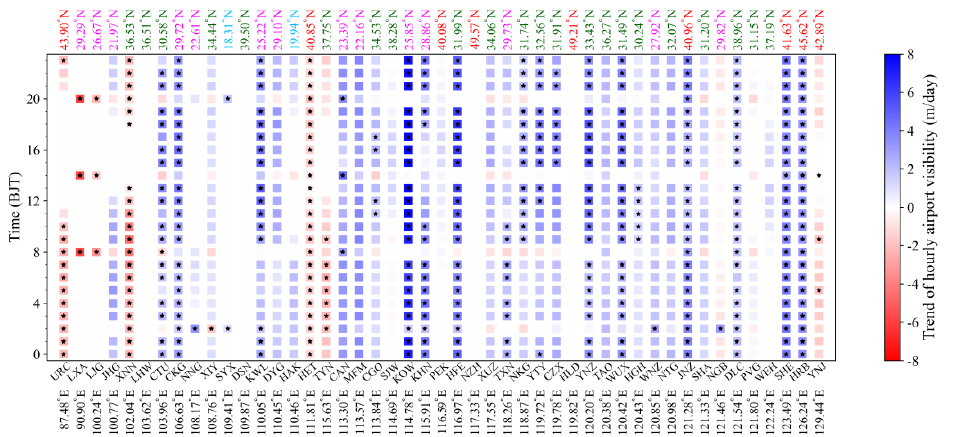
Figure 6. Trends of hourly visibility intraday distribution of at 47 international airports during 2010–2020. The airports are arranged left-to-right by longitude along the x-axis. Light blue, pink, dark green and red represent airports located between 10–19 ◦ N, 20–29 ◦ N, 30–39 ◦ N and 40–49 ◦ N, respectively. Stars represent statistically significant trends ( p <